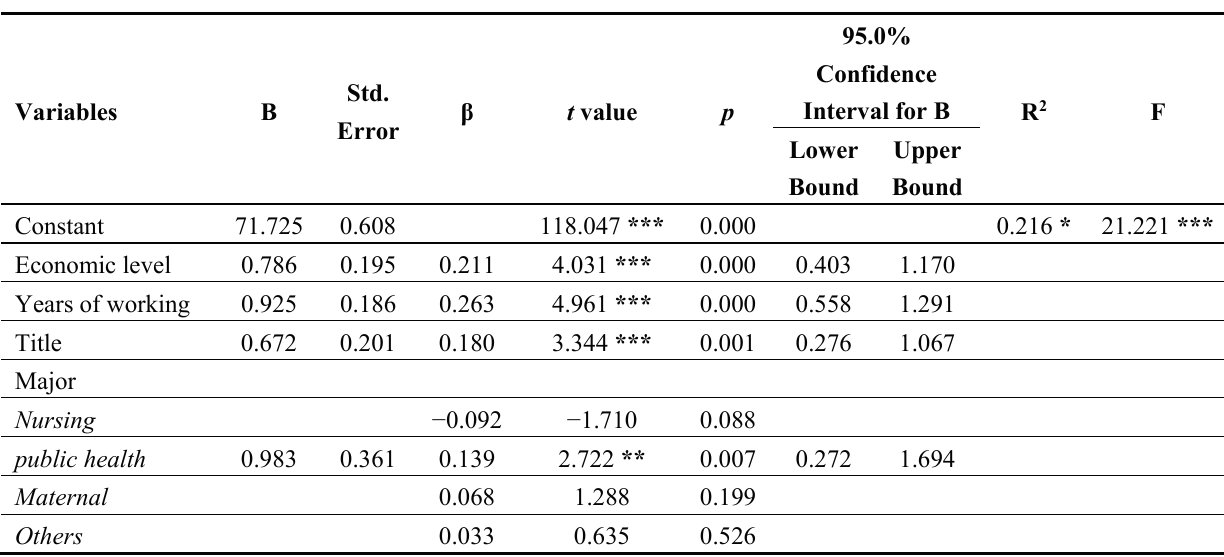
Table 5. Stepwise regression analysis of factors related to self-evaluation competencies ( N =